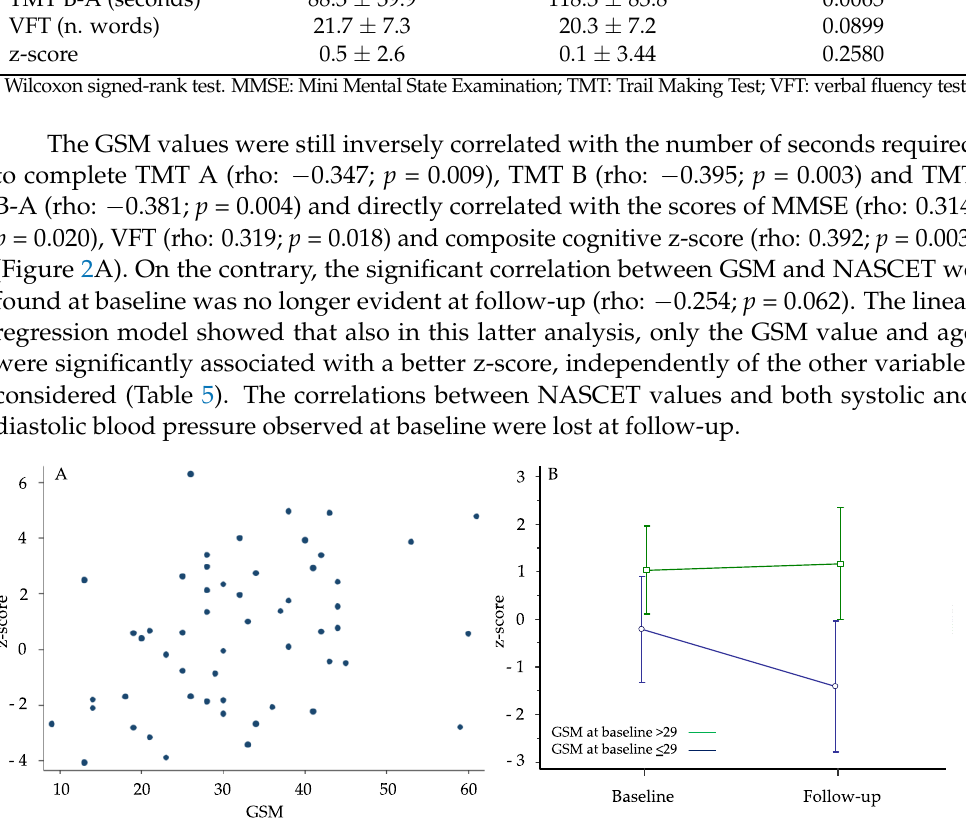
Table 5. Linear regression analysis for prediction of z-score at follow-up.